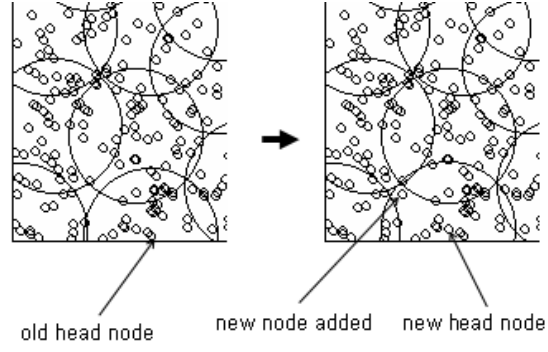
Figure 6. New added node can change cluster